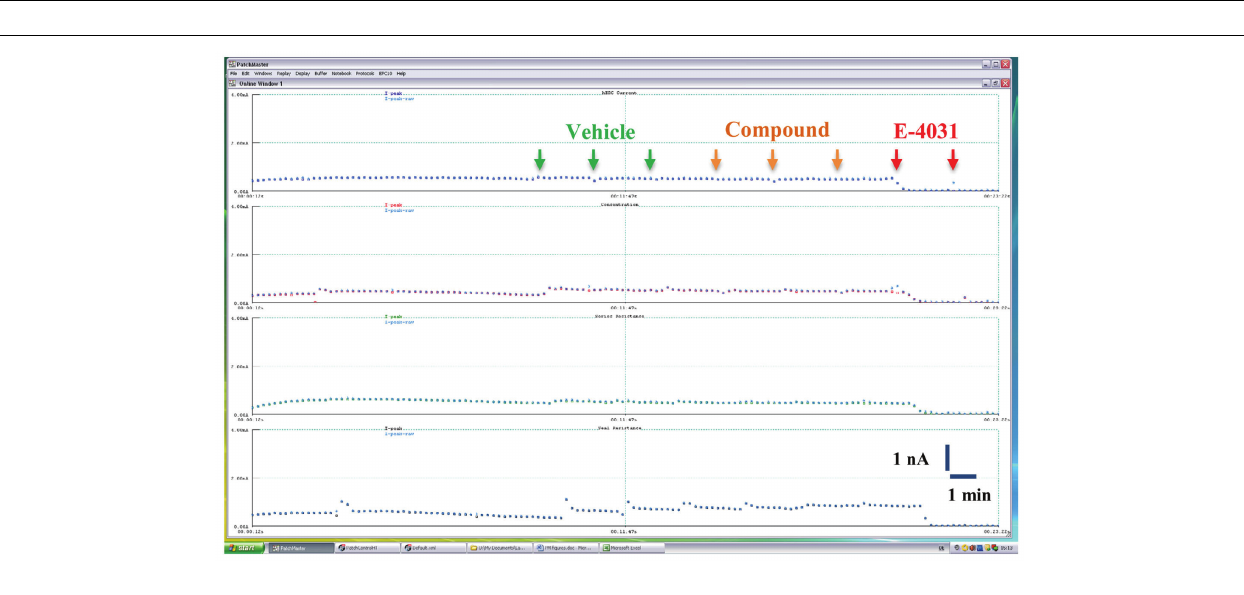
FIGURE 3 |Time course of hERG K + current amplitude recorded in a representative vehicle control experiment on the Patchliner ® . Cells were